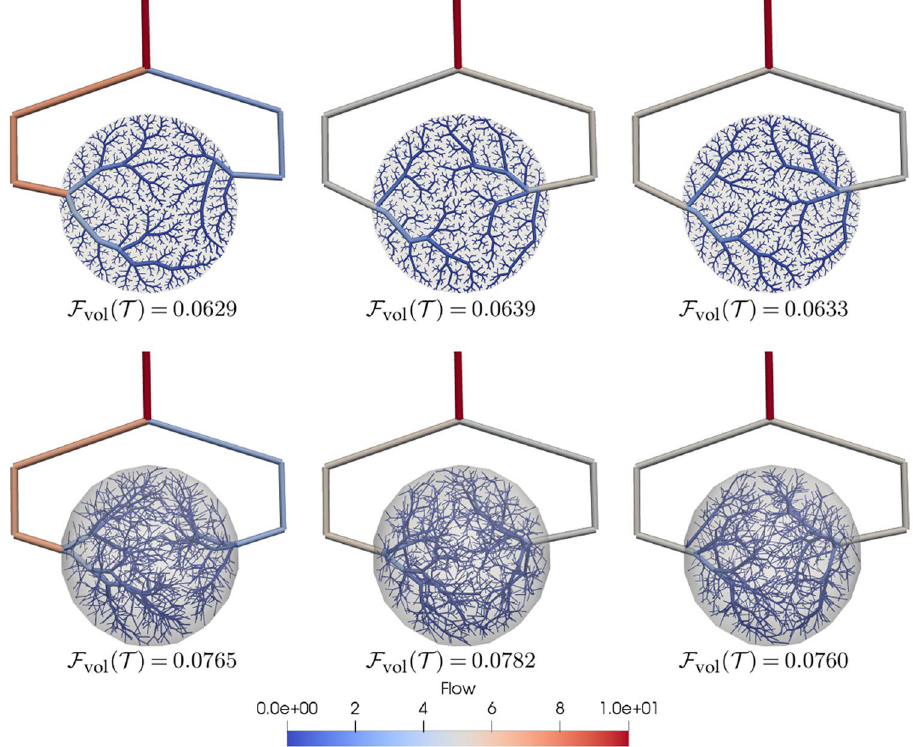
Figure 3. Concurrent vascularisation of circular and spherical domains with equiradial vessel inlets using: (left) volumetric cost criterion (standard CCO algorithm), S = { (cid:31) , P geo , P opt , T , 1000, F vol } ; (centre) sprouting cost criterion, S = { (cid:31) , P geo , P opt , T , 1000, F sprout } ; (right) 2-stage multi-criteria growing with S 1 = { (cid:31) , P geo , P opt , T , 25, F sprout } and S 2 = { (cid:31) , P geo , P opt , T , 975, F vol } . Parameters for central and right column cases are c v = 0.5 × 10 2 , c p = 0.5, c d = 1.0 and c v = 1.0 × 10 4 , c p = 0.5, c d = 1.0 for 2D